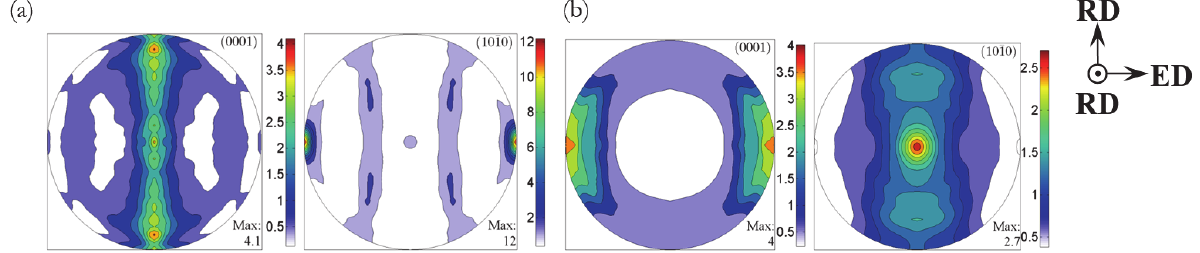
Figure 3: Calculated pole figure of AZ31B- extruded magnesium alloy in (a) as-extruded and (b) extruded followed by forging at a strain rates of 100